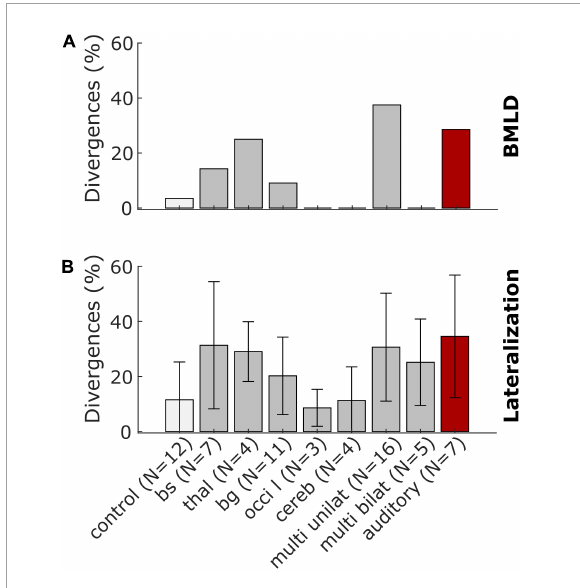
FIGURE6 Summary representations of the stroke-related binaural hearing deficits across patient groups. Panel (A) shows the percentage of patients who had BMLD-values that were worse (smaller) than the control group mean by more than 1.5 standard deviations or could not complete the task. Panel (B) shows the percentage of possible divergences of all values calculated for the lateralization patterns with error bars denoting the standard deviation across participants for the control and lesion